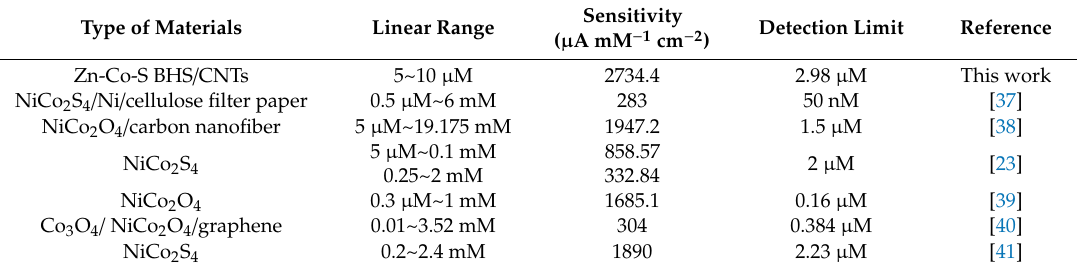
Figure 6. ( a ) Current-time plots and ( b ) calibration curve of Zn-Co-S BHS/CNTs in 0.1 M NaOH with successive addition of various glucose concentration at applying voltage +0.6 V. In inset of Figure 6a: the linear range of Zn-Co-S BHS/CNTs from 5 to 100 μ M. Table 1. Performance comparison of non-enzymatic glucose sensing based on ternary transition metal oxide/sulfide materials.